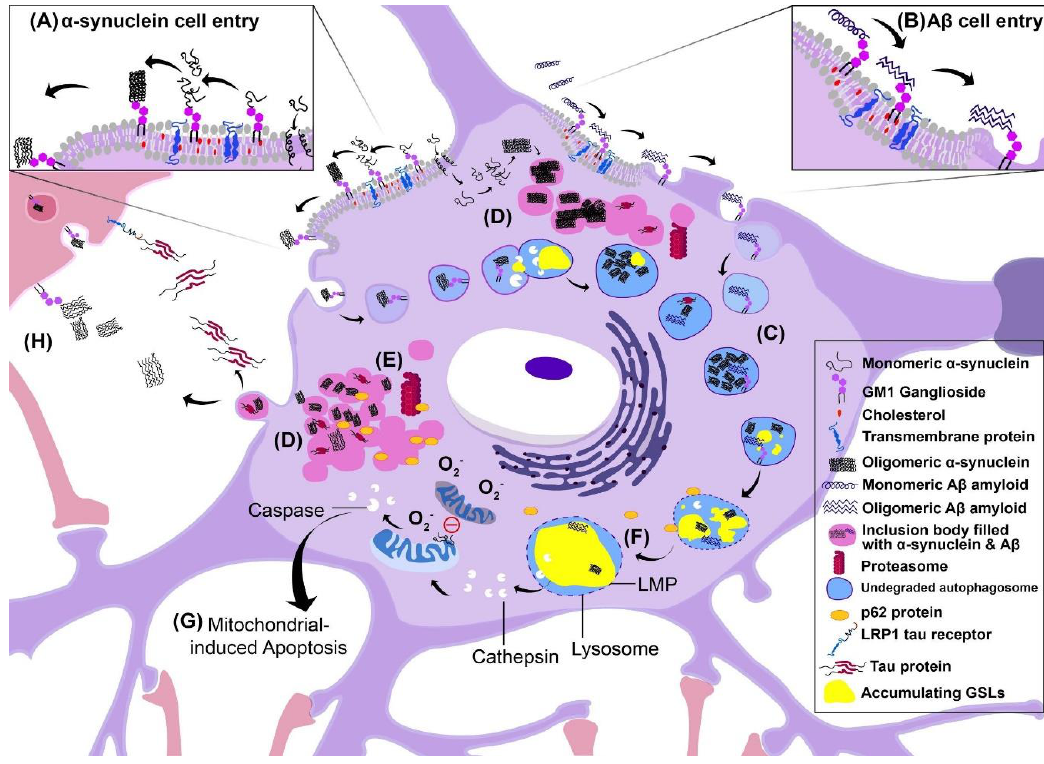
Figure 2. Schematic model of proposed pathophysiological mechanisms of lysosomal storage disorders (LSDs). The model is of the most affected cell type of LSDs, the neuron, and illustrates the events, which may indirectly or directly lead to cell death. A legend is presented on the right, which defines the symbols used in the figure. Several events are occurring simultaneously inside the diseased neuron: ( A ) α -synuclein cell entry, ( B ) A β cell entry, ( C ) accumulation of undegraded autophagosomes, ( D ) accumulation of cytoplasmic inclusion bodies filled with α -synuclein, A β or Tau protein, ( E ) inhibition of the proteasome, ( F ) lysosomal membrane permeability changes, ( G ) mitochondrial-induced apoptosis ( H ) and cell–cell spreading of pathology. ( A ) α -synuclein enters the cell via GM1-receptor mediated endocytosis or by creating a pore in the membrane leading to the formation of inclusion bodies (seen in pink) that inhibit the proteasome and reduce degradation of materials in the cell. ( B ) A β amyloid enters the cell via the same method: GM1-mediated endocytosis. ( C ) Autophagosomes fill with undegraded material such as the accumulating proteins α -synuclein, A β and Tau. ( F ) Due to defective lysosomal hydrolases, GSLs accumulate in the lysosome and promote lysosomal membrane permeability (LMP). ( G ) Eventually the lysosome expels its contents including cathepsins. This induces mitochondrial release of caspases, which in turn cause apoptosis. Additionally, monomeric α -synuclein is capable of inhibiting mitochondrial fusion. As a result, the dying mitochondria degrade in the cytoplasm, releasing copious amounts of reactive oxygen species inducing cell death. ( H ) As the cell fills with undegraded autophagosomes, and harmful inclusion bodies, the cell activates secretory pathways that lead to the exocytosis of intracellular material to reduce the load, followed by endocytosis in adjacent cells. This provides a route for pathology to spread to adjacent cells. Harmful aggregates such as from Tau, α -synuclein and A β can be endocytosed into the adjacent cell. Specifically, Tau can interact with the receptor LRP1 to allow cell